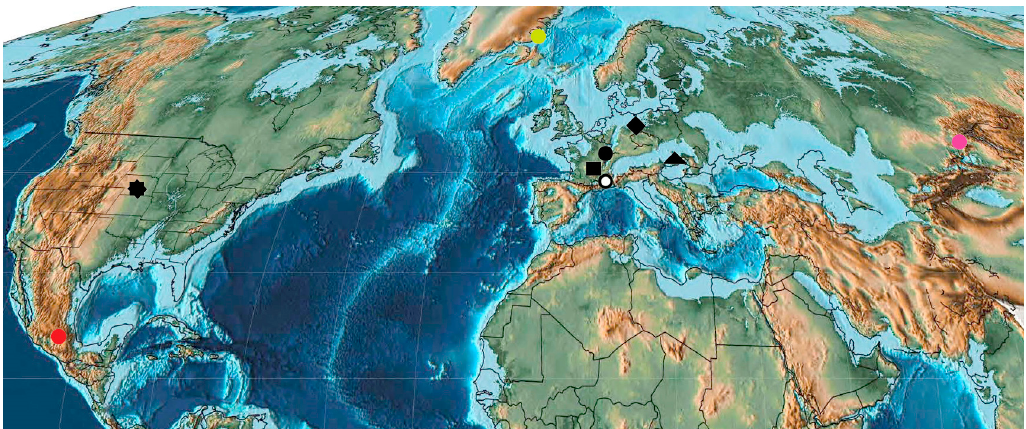
Figure 20. Rupelian Curculionoidea deposits: octagon—White River Badlands; circle—Brunnstatt; square—Corent; ring—Cereste; rhombus—Seifhennersdorf; red circle—Ahuehuetes; triangle—Kundratice; yellow circle—Kap Dalton; pink circle—Kenderlyk II.